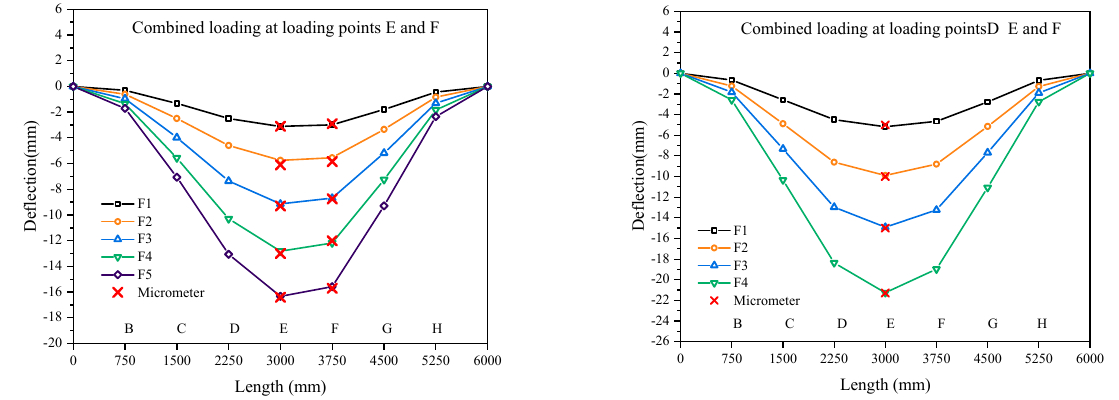
Figure 8. Schematic diagram of the shape of the truss.